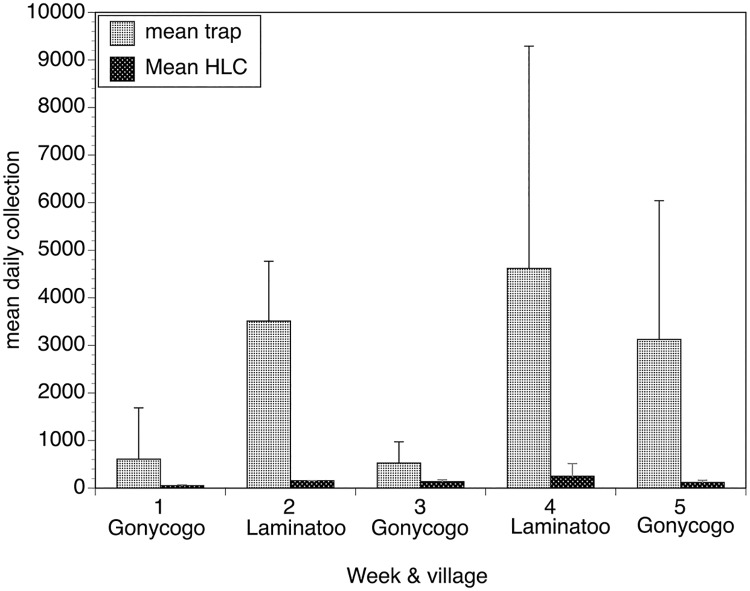
Daily collections obtained by traps and by the human landing collector located in the fields of Gonycogo and Laminatoo.Bars represent the mean daily collection obtained by each of the five individual traps situated around the two fields in each village and the mean collection obtained by the two HLCs situated in each field over the five weeks of the study. Error bars depict the standard deviation surrounding the mean daily collections. Data from each week were calculated from six days of human collection data and 30 days of trap collection data. Raw collection data for this study may be found in the S6 Table.